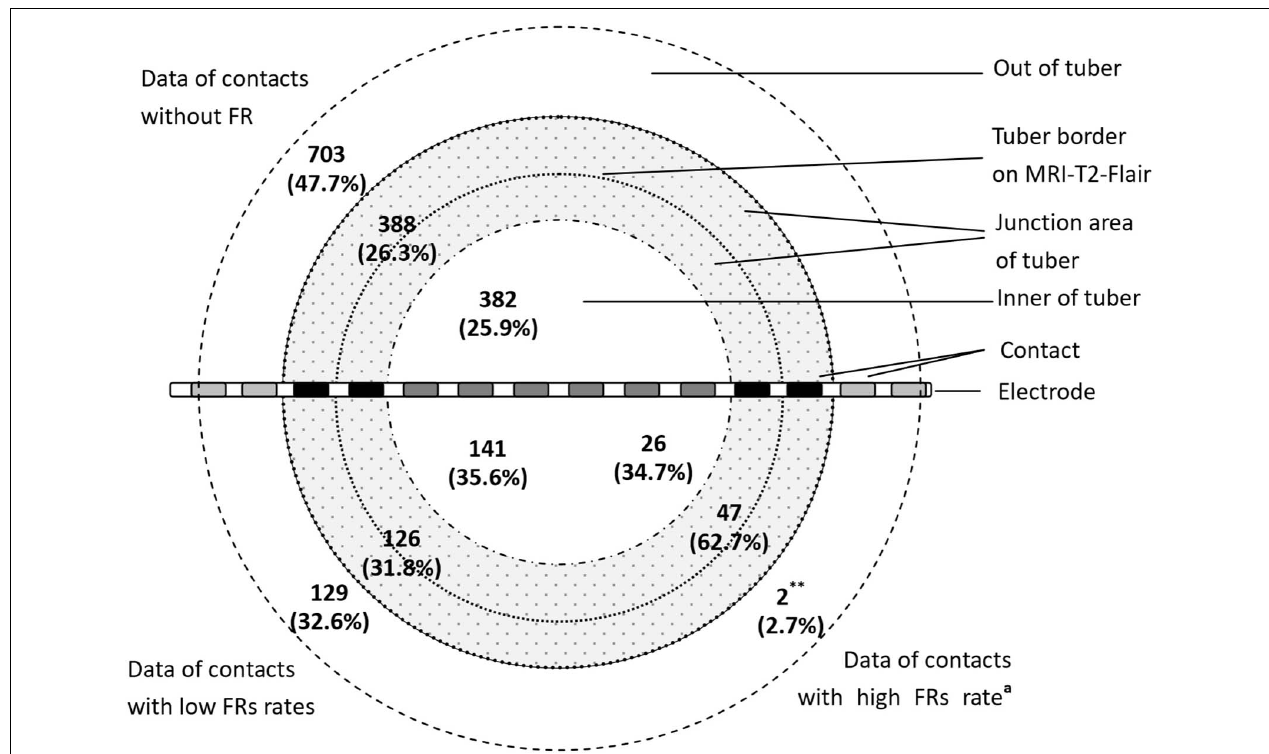
FIGURE 1 | The distribution of contacts with FRs in different parts of tubers ( ∗∗ P < 0.01, the data in this group compared with the data of contacts without FRs and data of contacts with low FR rates. a The ratio of the high FR rate was more than 0.5). The figure shows distribution of FRs across different parts of the tuber. The majority of the high FR rate (ratio of occurrence frequency of fast ripples > 0.5) presented in the junction area of the =